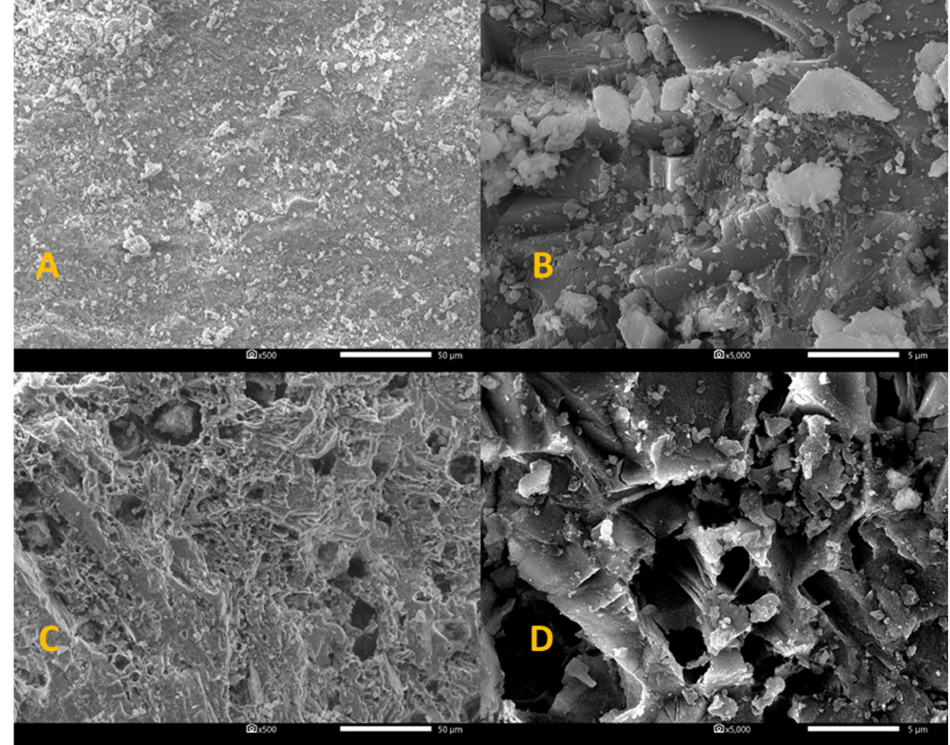
Figure 5. SEM images of the untreated phonolite ( A ) { × 500}, ( B ) { × 5000}) and acid-treated phonolite ( C ) { × 500}, ( D ) { ×